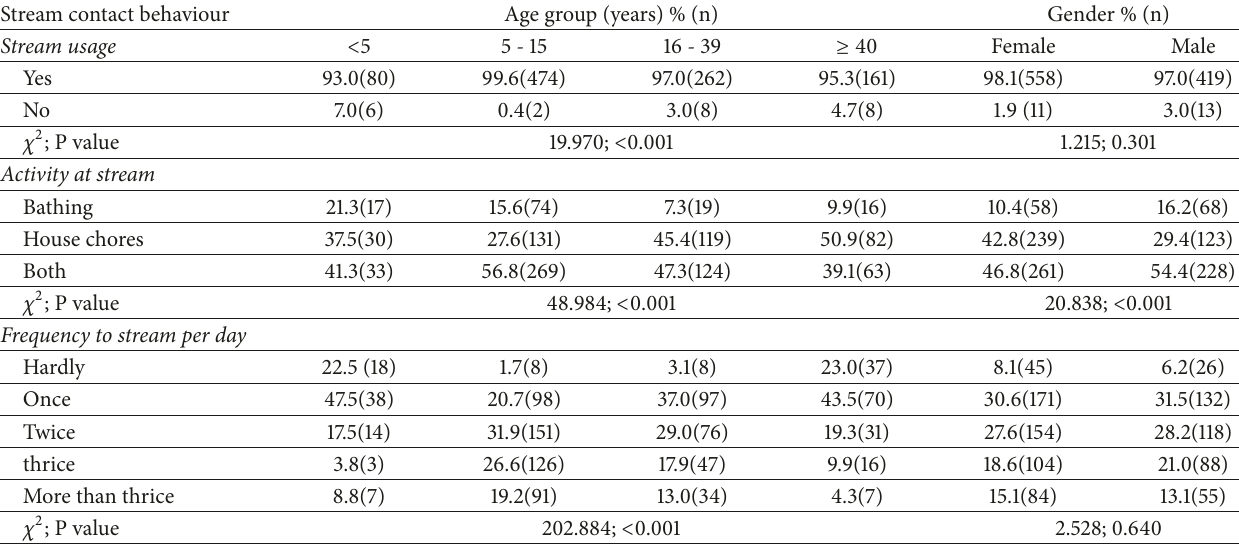
Table 3: Association between age, gender, and stream contact